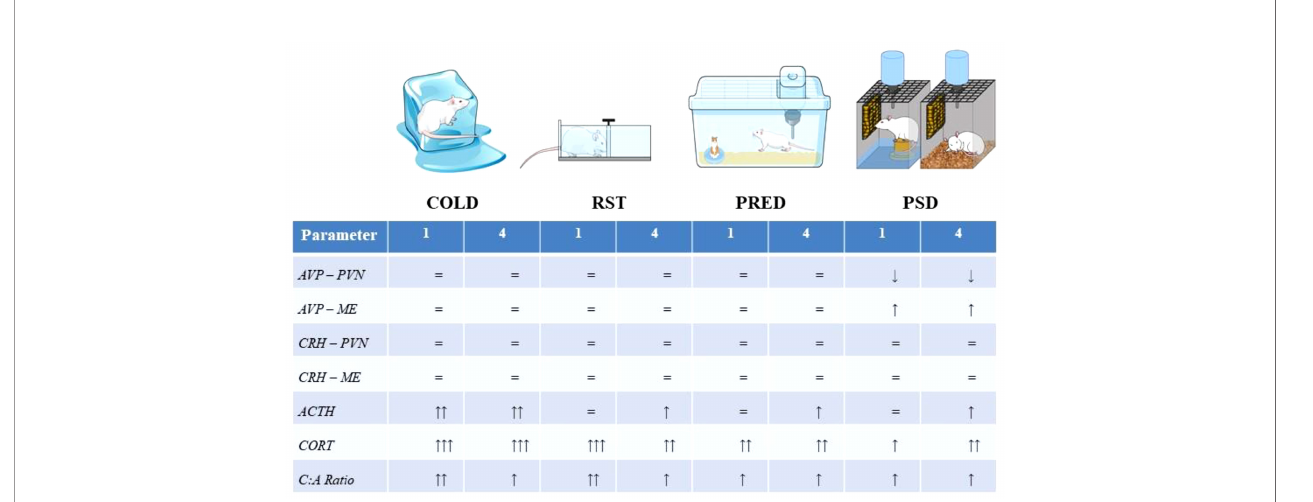
FIGURE 9 | Representation of the stressors used in the present study and the magnitude of the response at each level of the HPA axis. The Abbreviations: ACTH, adrenocorticotropic hormone; AVP, arginine-vasopressin; C:A ratio, CORT, ACTH ratio; COLD, cold stress; CORT, corticosterone; CRH, corticotropin releasing hormone; ME, median eminence; PRED, predator scent; PVN, paraventricular nucleus of the hypothalamus, RST, restraint